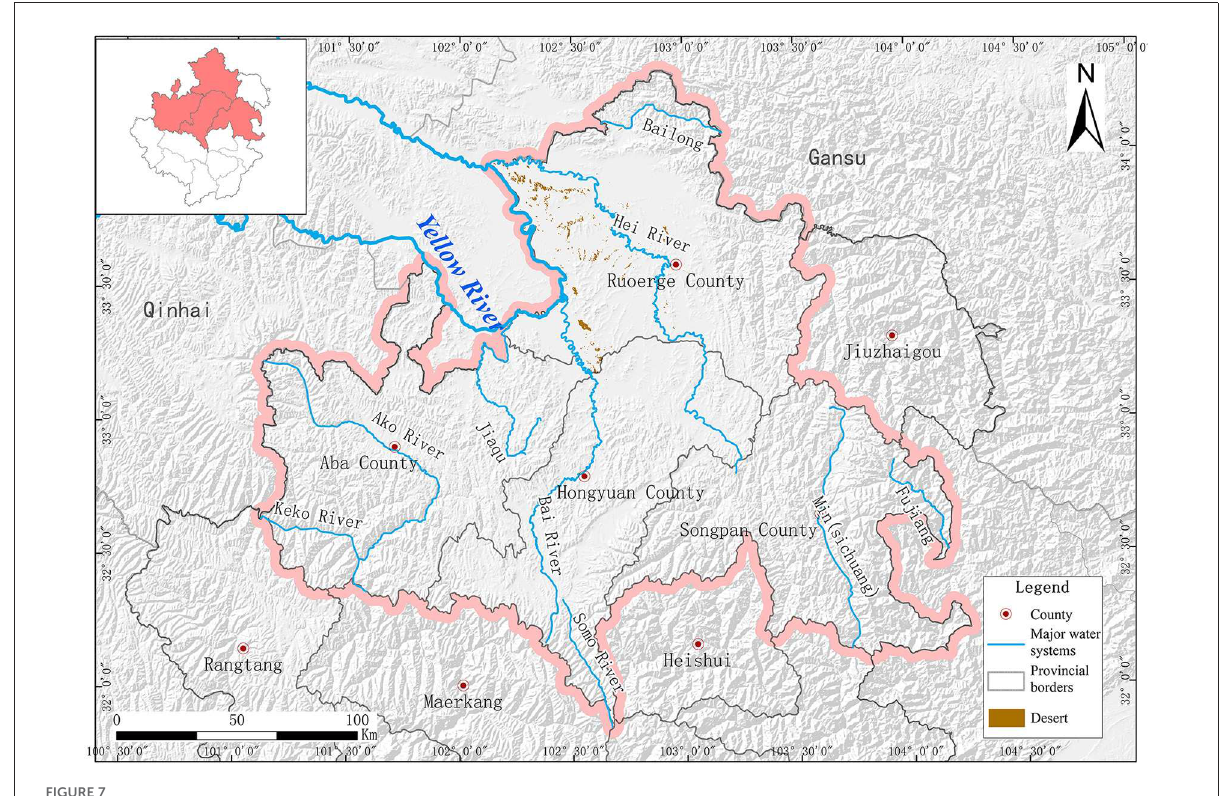
FIGURE7 Desert ecosystem distribution in the study